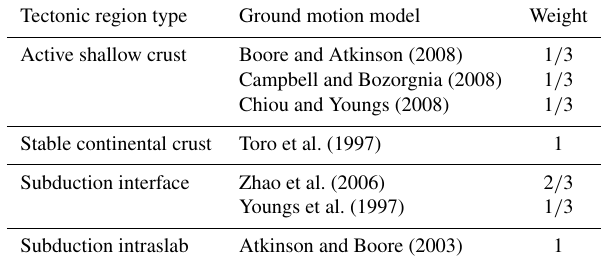
Table 1. Ground motion models and corresponding weights used by the hazard model for different tectonic region